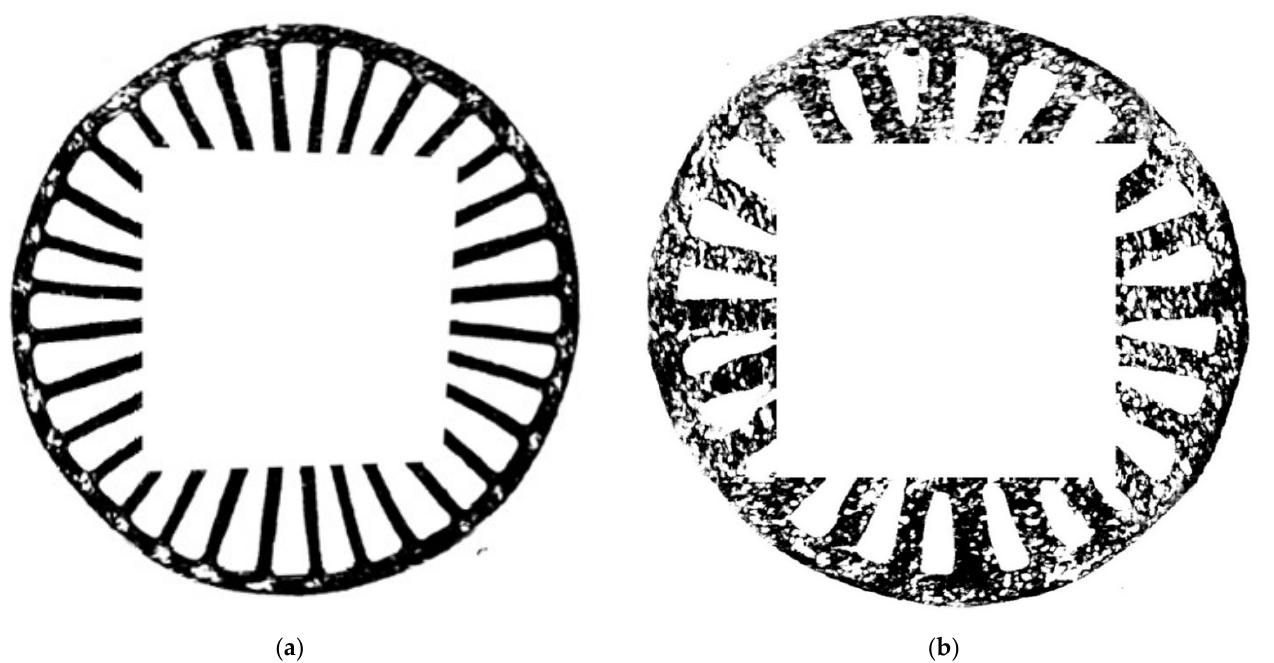
Figure 15. The amplitude mode merged UT C-scans of ( a ) larger and ( b ) smaller disks.